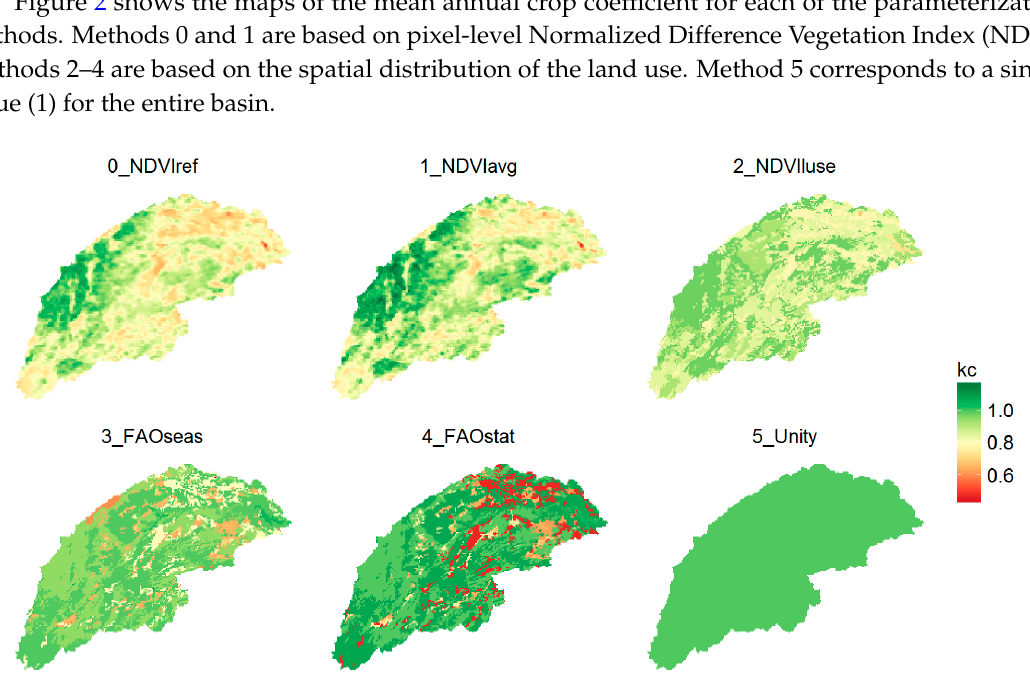
Table 1. Description and inputs for the crop coefficient parameterization methods used